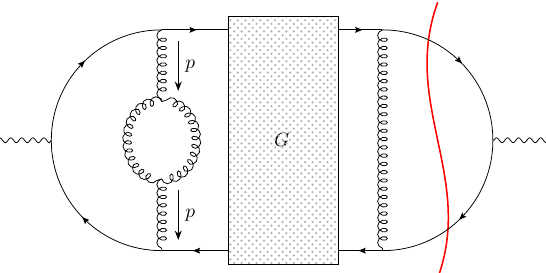
Figure 6. Example of an amplitude diagram featuring a spurious local soft singularity in the limit p µ → 0 (i.e. spurious because it leads to no pole at the integrated level) due to the insertion of a self-energy subgraph on an internal loop line. The cancellation of such a spurious soft singularity is completely unrelated to the KLN cancellation pattern, and its regularisation within the LU integrand therefore necessitates a subtraction